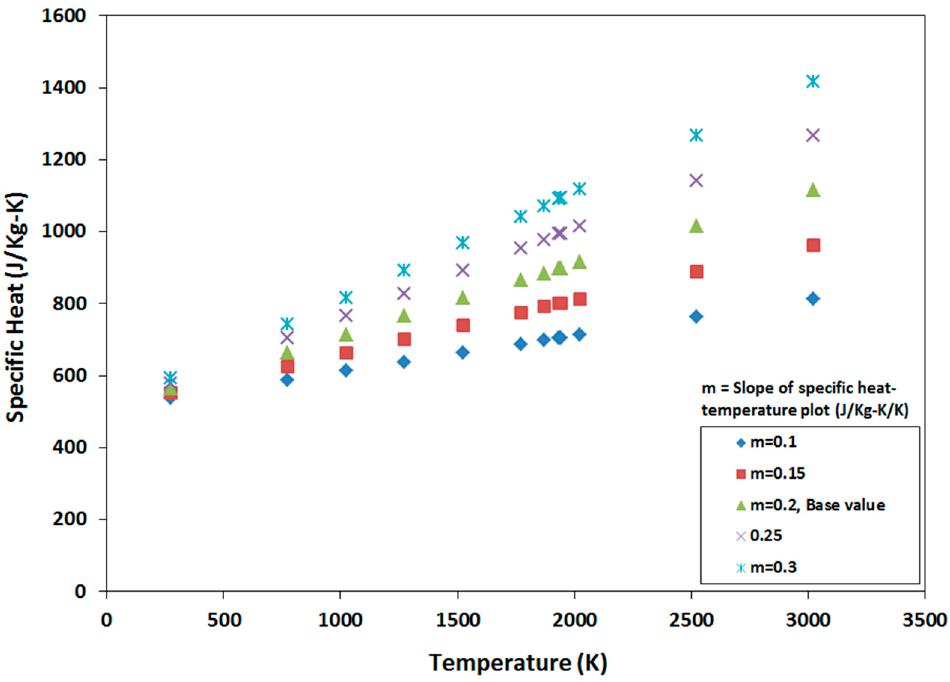
Figure 9. Sets of specific heat data by varying its slope from the base slope of 0.2 J/kg-K/K .